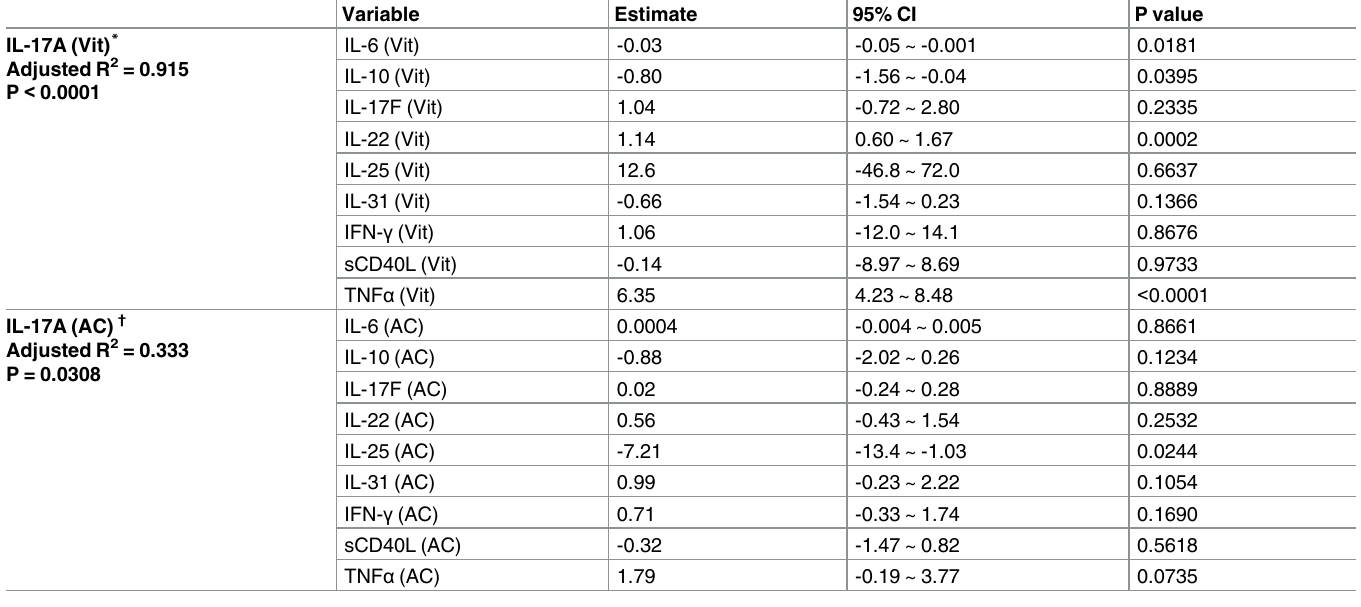
Table 2. Multiple regression analysis of IL-17A level with other cytokine levels in aqueous humor and vitreous fluid of patients with proliferative diabetic retinopathy (PDR). Variable Estimate